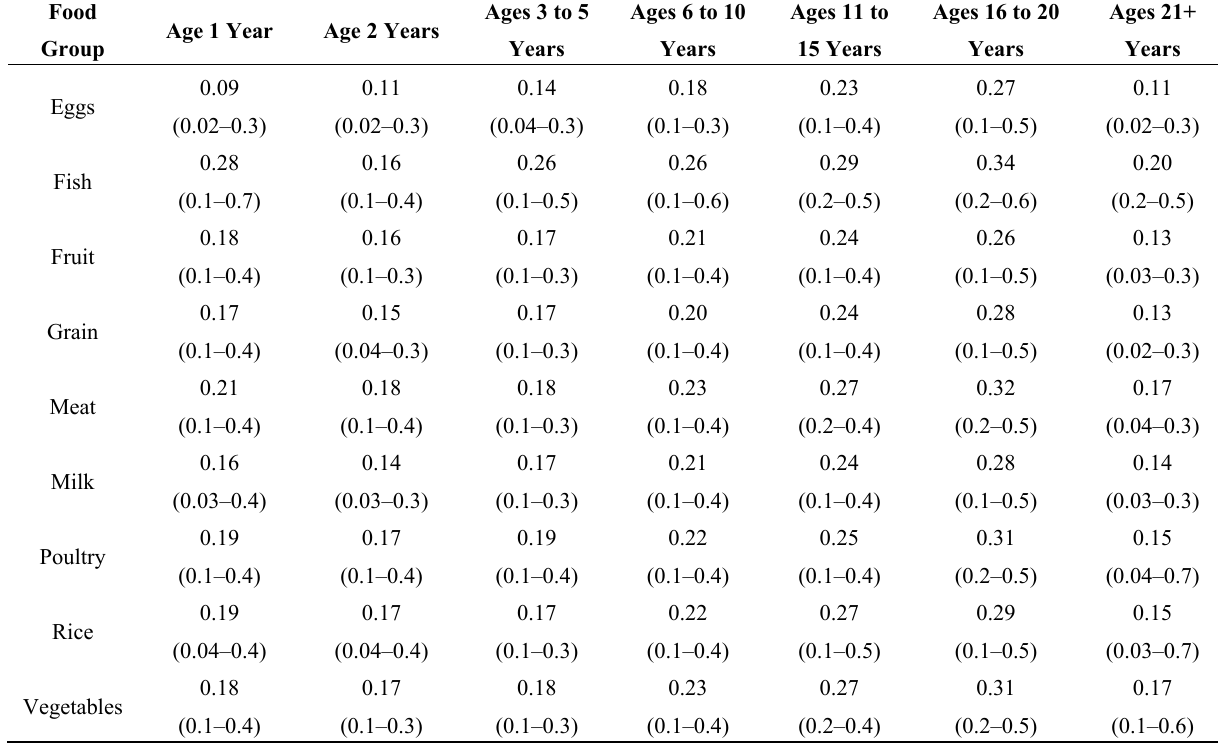
Table A4. Fraction of food group consumed canned by mass (not adjusted for body weight), by age group and food group (NHANES 2003–2008). Value in cell is median (interquartile